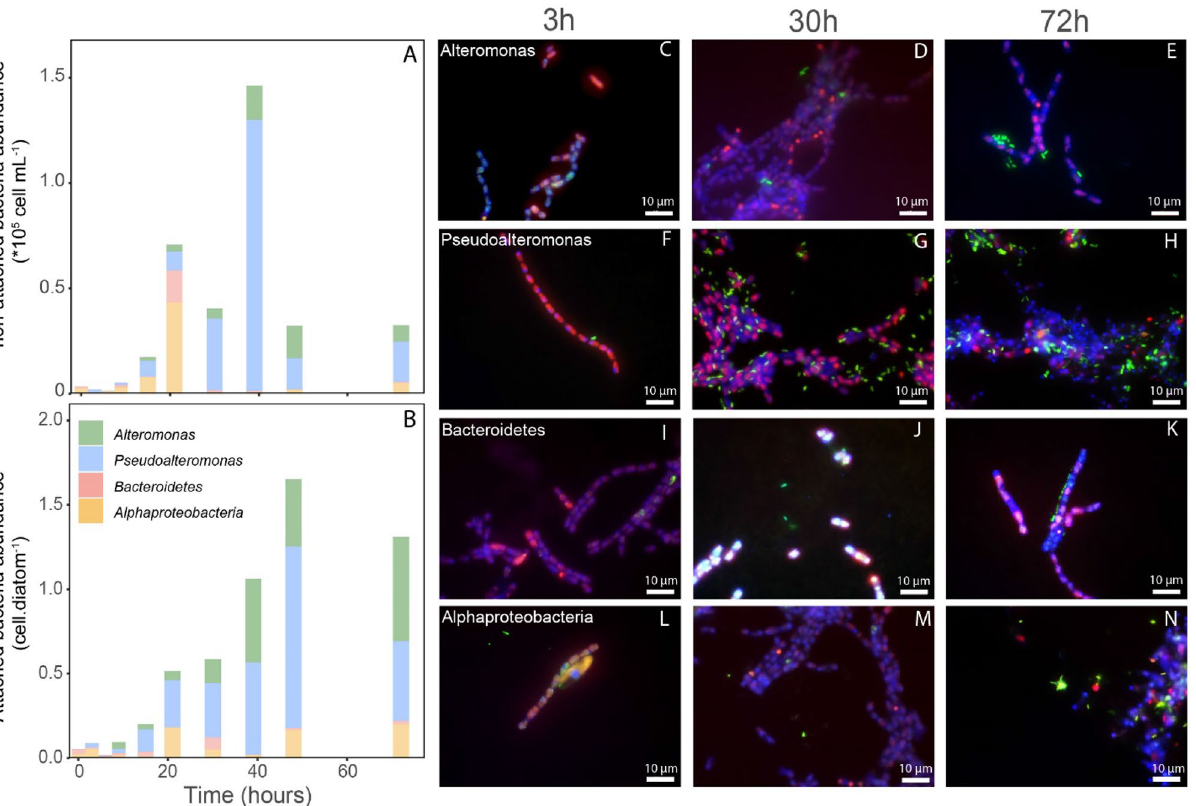
Figure 1. Bacterial abundances of various groups within aggregates targeted by CARD-FISH as a function of incubation time (h) for the non-attached ( A ) and attached fractions ( B , expressed as number of bacterial cells per diatom). Images in the right panel show epifluorescence microscopy images at different time points for Alphaproteobacteria ( C – E ), Alteromonas ( F – H ), Bacteroidetes ( I – K ) and Pseudoalteromonas ( L – N ) (depicted in green after CARD-FISH with Alexa488-labelled tyramides) (non-)attached to diatom filaments (depicted in red due to their natural chlorophyll autofluorescence). Blue color is given by counterstaining with DAPI of hybridized